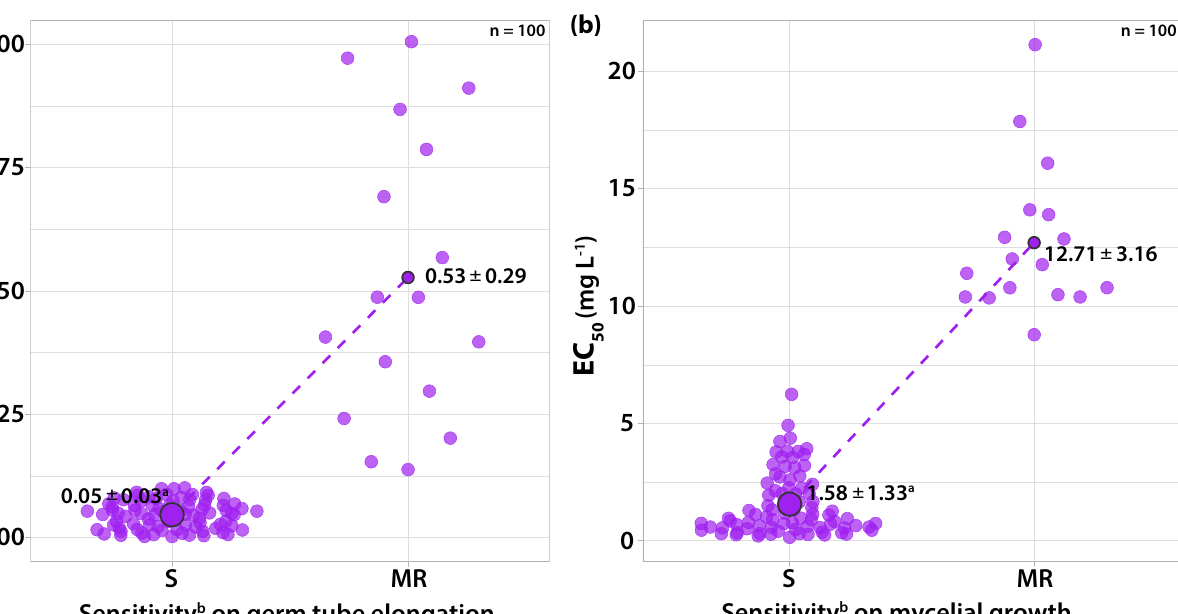
Figure 7. Frequency of sensitivity distribution for one hundred V. inaequalis isolates to fludioxonil on ( a ) germ tube elongation and ( b ) mycelial growth. The mean EC 50 values for the moderately resistant population of V. inaequalis were significantly higher ( p < 0.05) than the mean EC 50 val- ues of the sensitive population on both tests according to the Welch’s t -test. a Average values of sensitivity groups ± standard deviation; circle size reflects the population number. b Sensitivity groups: S, sensitive; MR, moderately